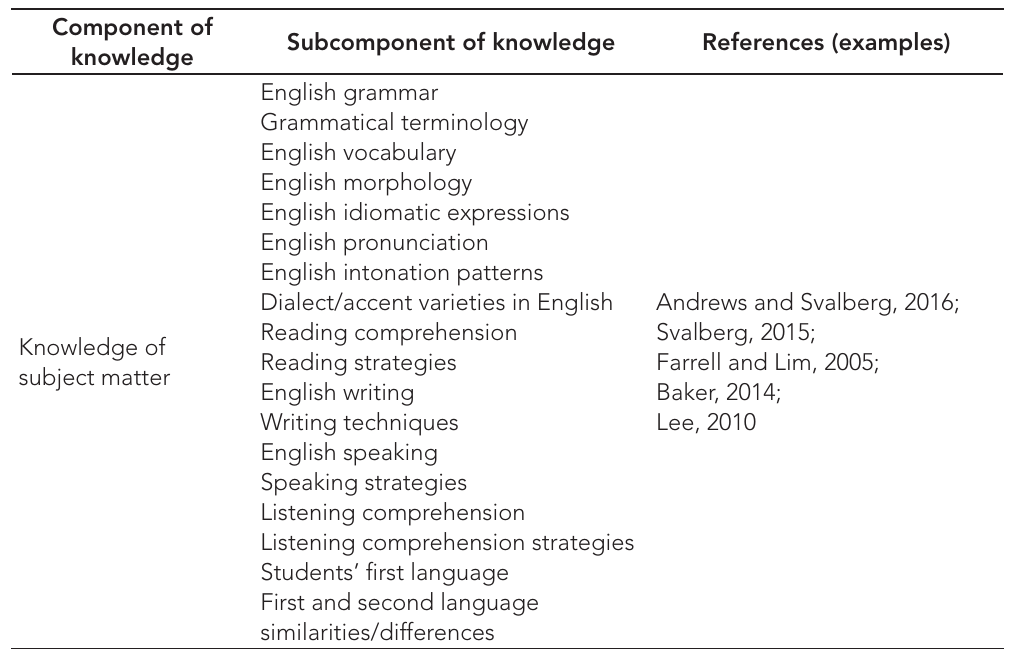
Table 1: A tentative framework for pedagogical knowledge in teaching Component